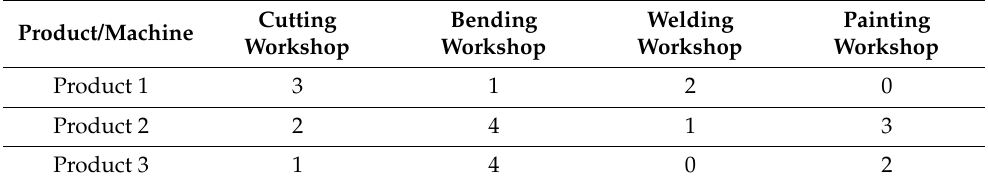
Table 12. Operational process chart of the case study.